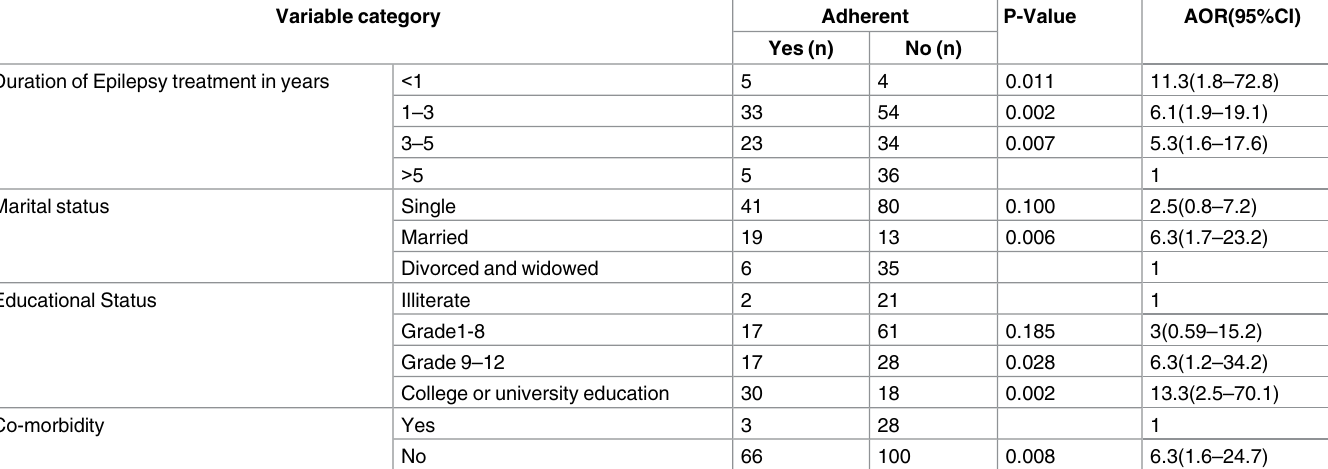
Table 4. Independent factors affecting adherence of epileptic patients to antiepileptic medications at Yirgalem General